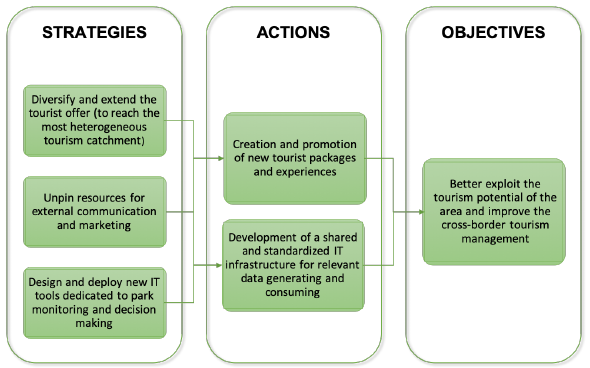
Figure 2. Summary of the INSUBRIPARKS project strategies, actions, and